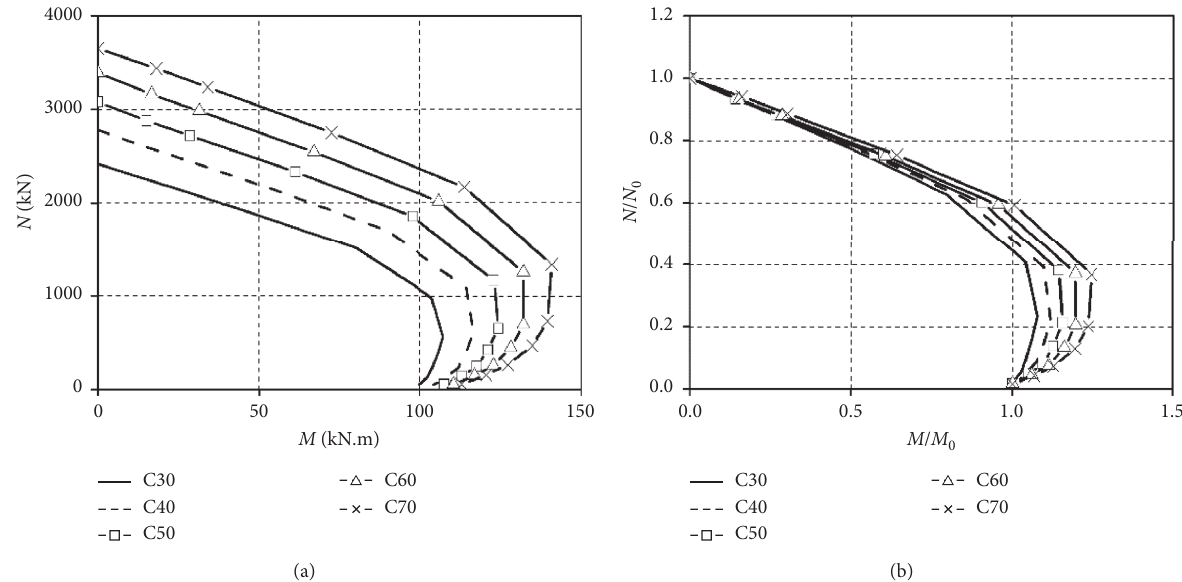
Figure 8: Influence of concrete strength ( f ) ck on the resistance correlation curves. (a) Forward loading. (b) Forward loading